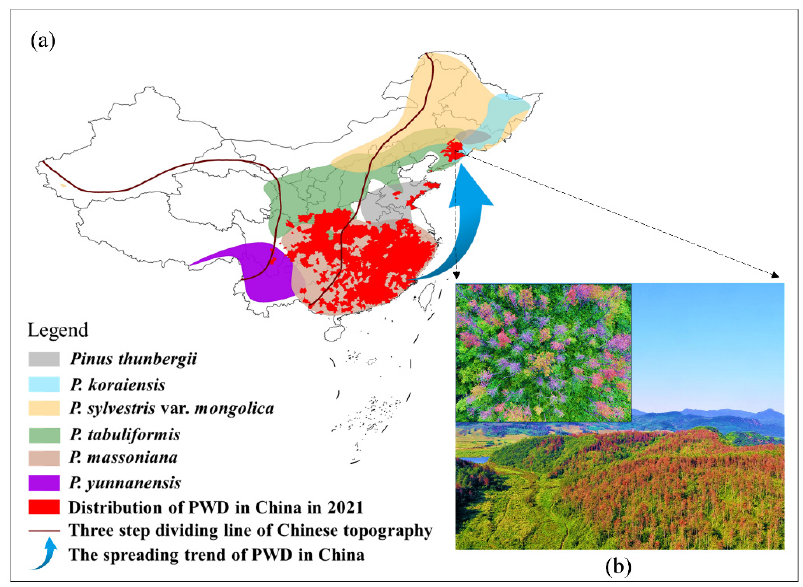
Figure 3. ( a ) Distribution of pine wilt disease (PWD) and major pine species susceptible to PWD in China. ( b ) PWD has caused a large area of death of pine forests in northern China.